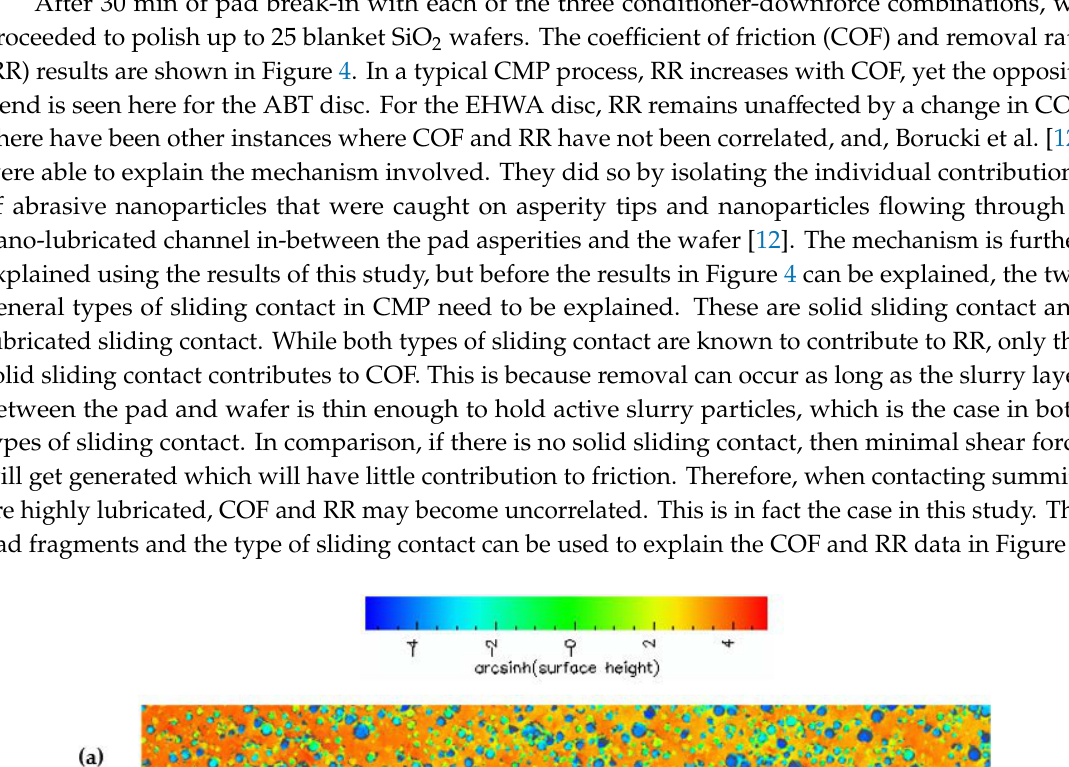
Figure 3. Surface height probability density functions (PDFs) corresponding to Figure 2.